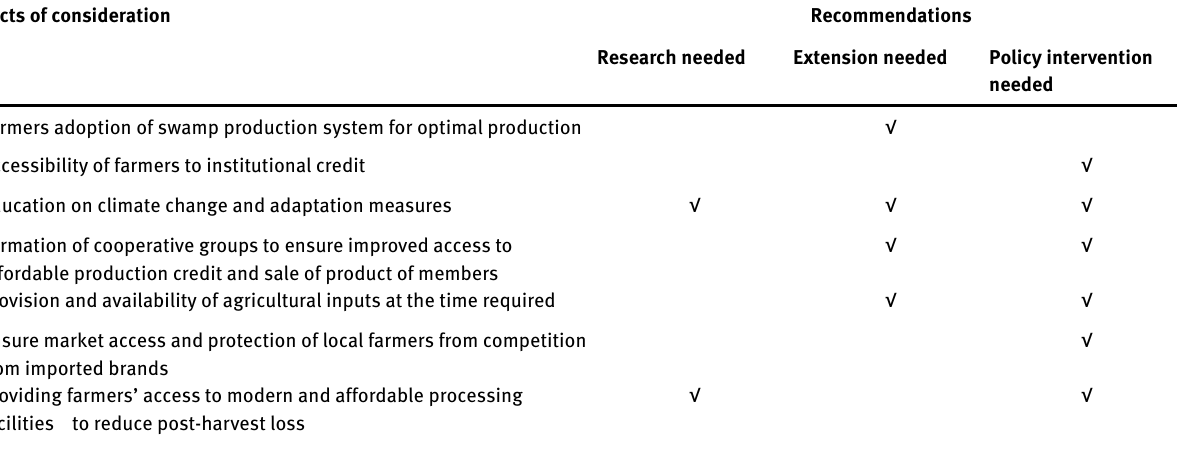
Table 9: Recommendation matrix indicating issues that needed further research, extension and policy intervention Facts of